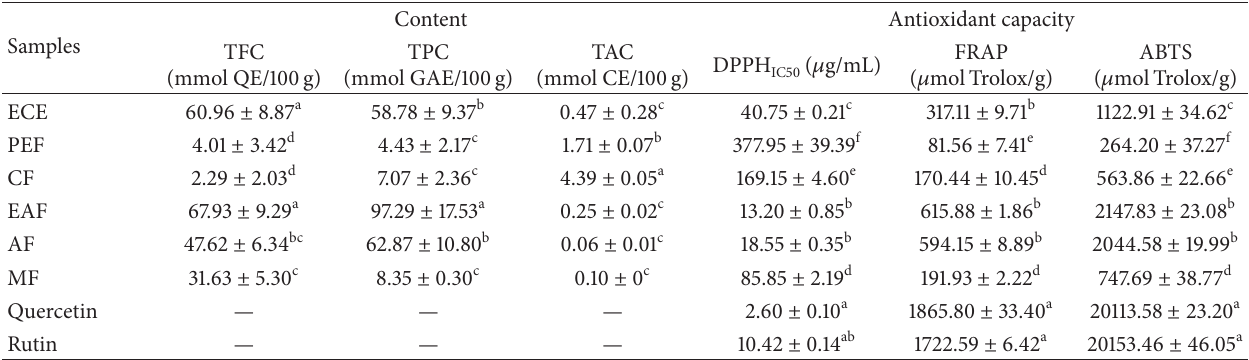
Table1:Contentoftotalflavonoid,phenolic,andalkaloidandantioxidantcapacityofethanolextractsanditsfivefractionsfrom Z.bungeanum